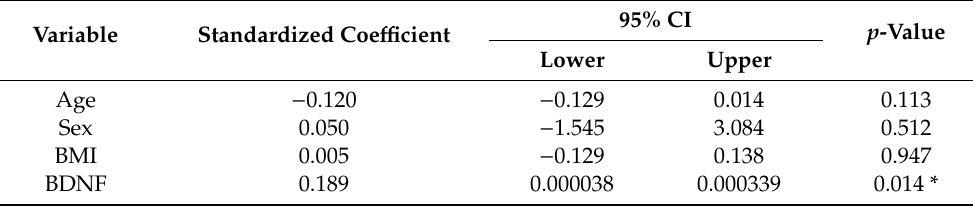
Table 4. Multivariable Linear Regression for Low Risk Group ( n =